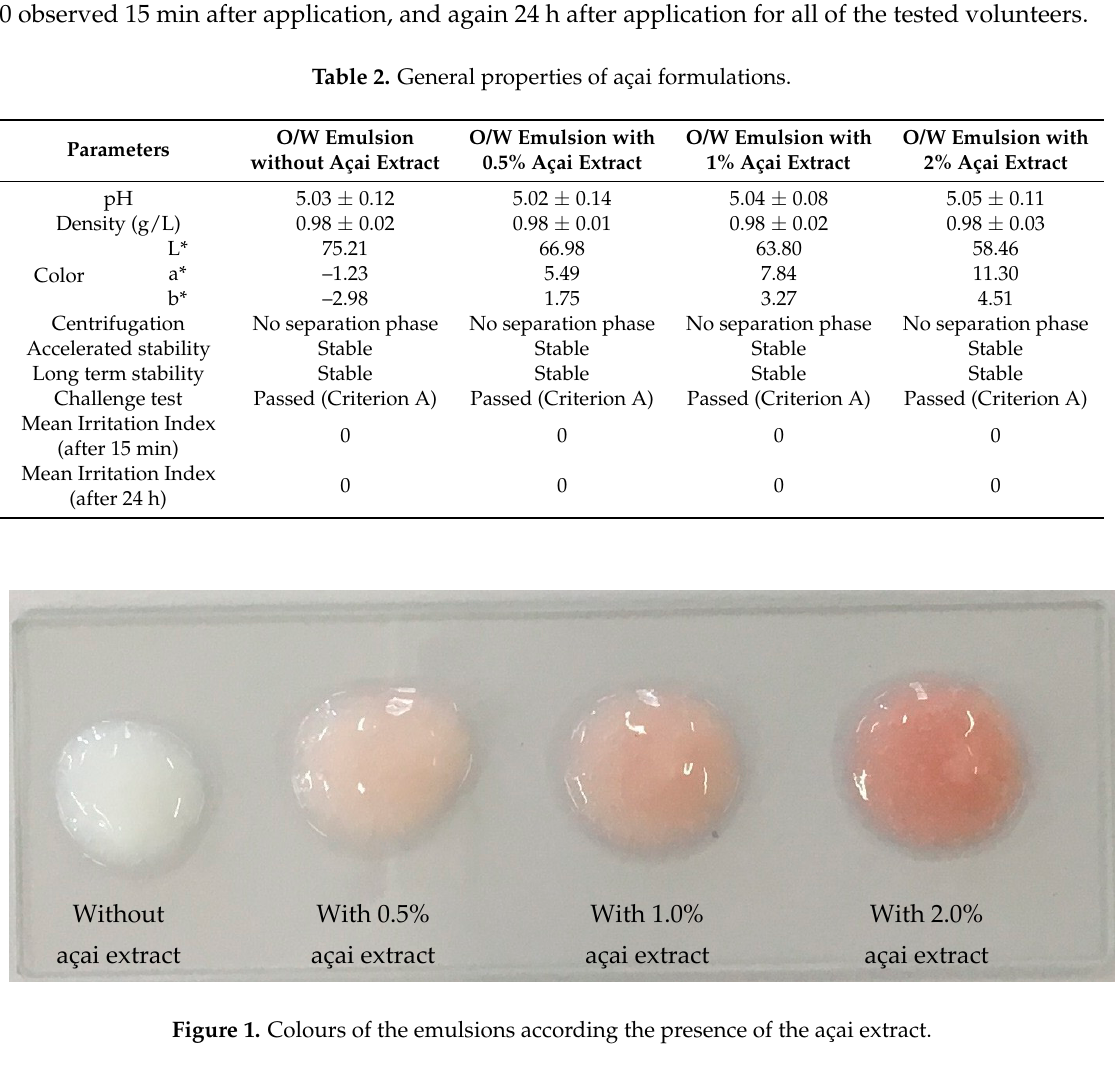
Table 2. General properties of açai formulations.